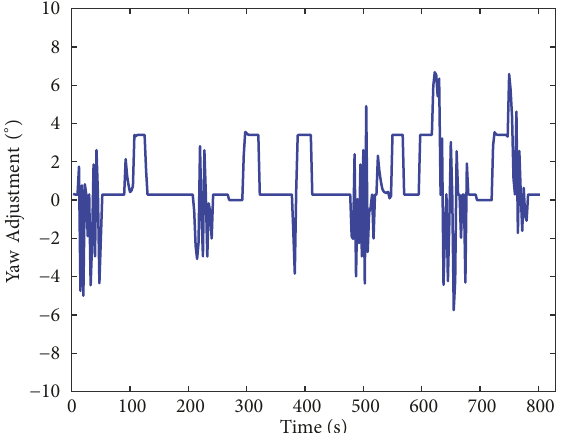
Figure 17: Curves of yaw adjustment output by LSTM45 in simulation test case